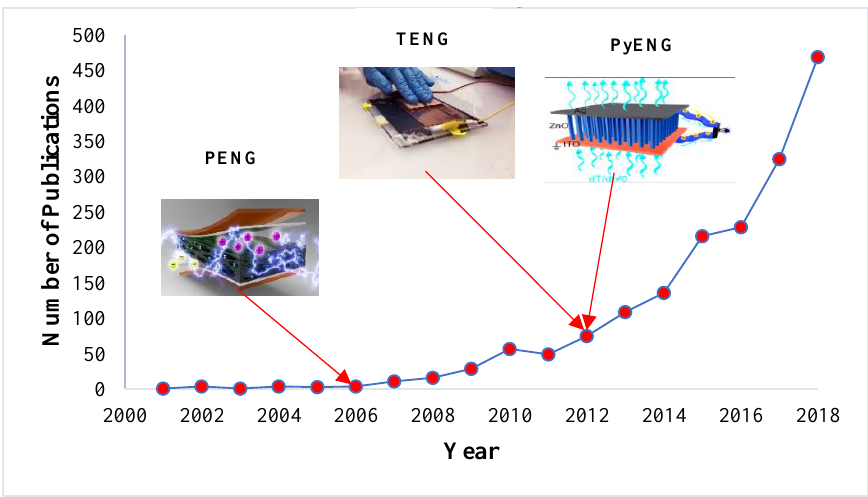
Figure 2. Different types of nanogenerators and their applications in the era of the Internet of Things (IoT).